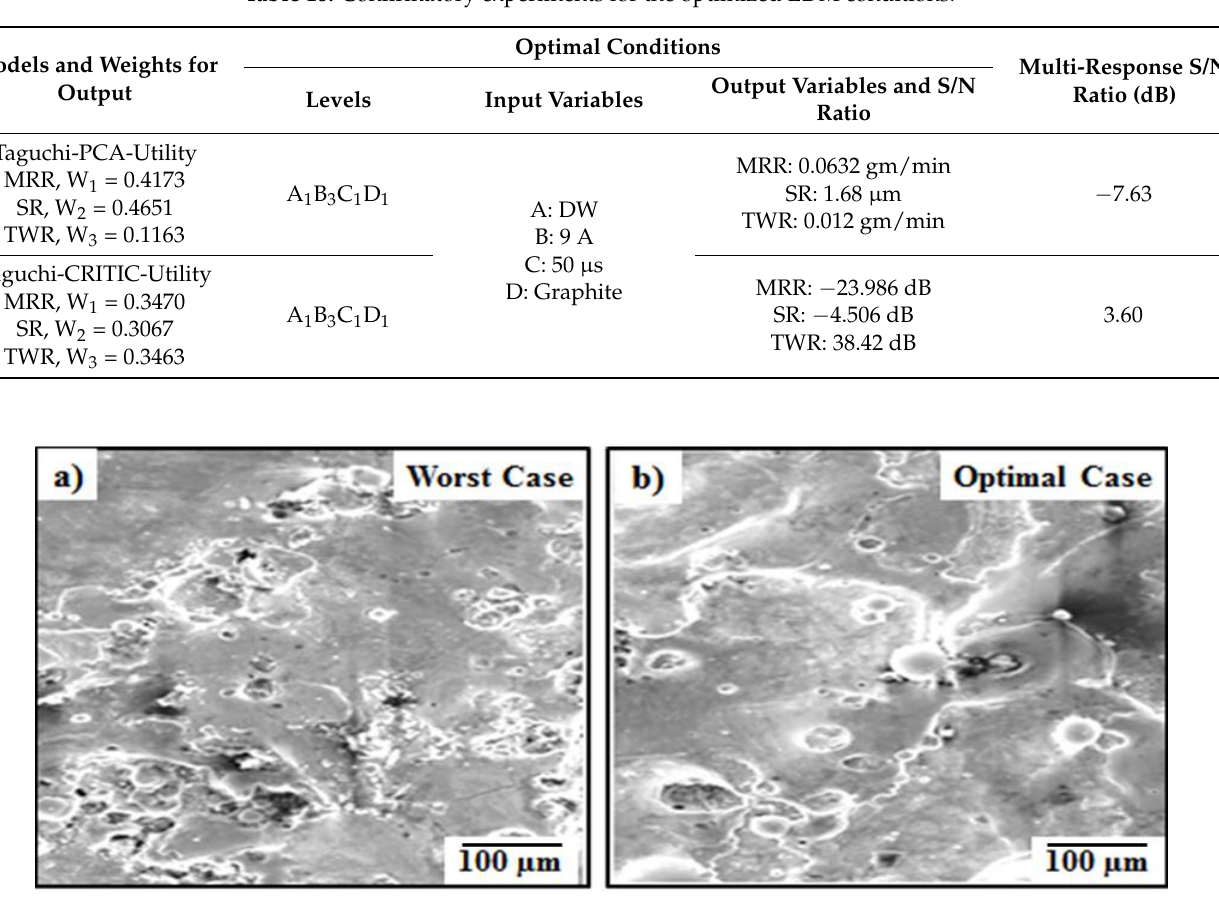
Table 18. Confirmatory experiments for the optimized EDM conditions.